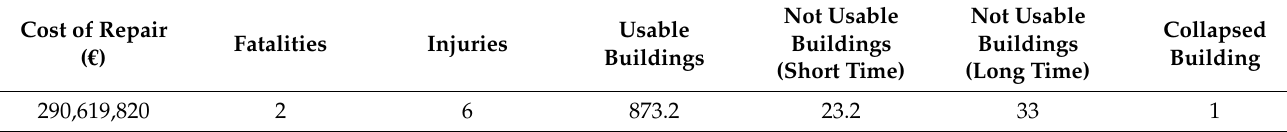
Table 7. Total losses.